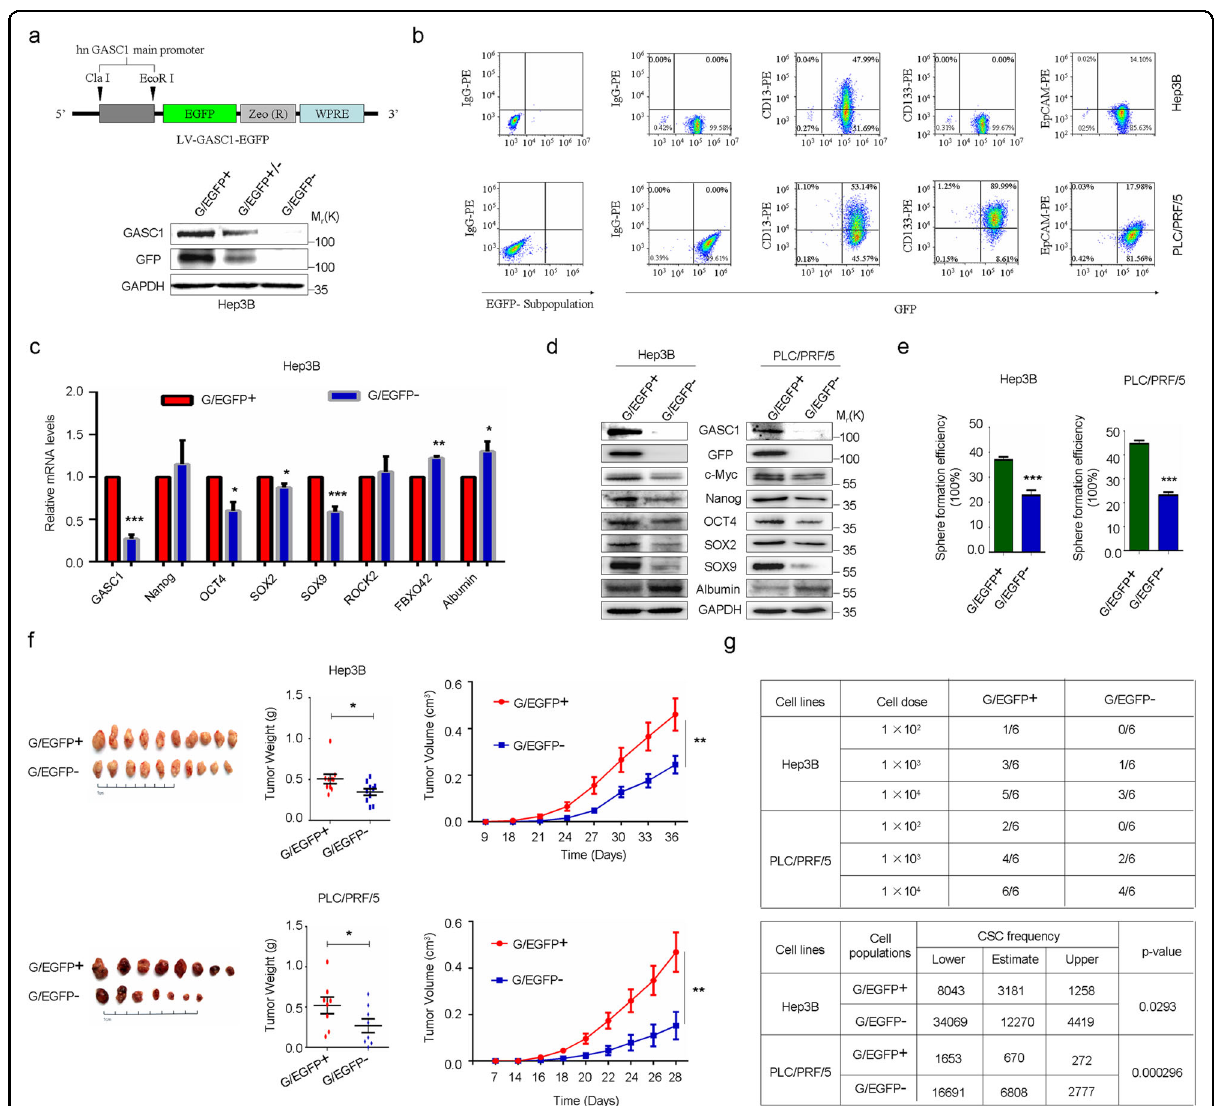
Fig. 2 GASC1 expression de fi nes the label-retaining CSC characterization in HCC. a Schematic map of lentiviral vector LV-GASC1-EGFP, in which EGFP and Zeocin expression were controlled by human GASC1 promoter (upper panel). Immunoblot (IB) of sorted populations showed a signi fi cant positive correlation between exogenous EGFP and endogenous GASC1 expression in Hep3B cells after infection with LV-GASC1-EGFP (lower panel). b Flow cytometric determination of the co-expression of G/EGFP + with CD13, CD133, or EpCAM in HCC cell lines (Hep3B and PLC/PRF/5); the G/ EGFP- subpopulation represents a negative control group. c , d qRT-PCR ( c ) and immunoblotting ( d ) evaluation of the mRNA and protein levels of indicated genes in FACS-sorted subpopulation (G/EGFP + and G/EGFP − ). Data are presented as mean ± SEM of three independent experiments. * P < 0.05; ** P < 0.01; *** P < 0.001 by Student ’ s t test. e The G/EGFP + subpopulation showed an increased oncosphere formation capacity at Day 14 of the assay. Data are presented as mean ± SEM of three independent experiments. *** P < 0.001 by Student ’ s t test. f Xenograft tumor growth assay of sorted G/EGFP + and G/EGFP- subpopulation of Hep3B and PLC/PRF/5 cells in NOD/SCID mice. Tumor image (left panel) and tumor weight (middle panel) are presented. Tumor growth was measured at the indicated time points and tumors were dissected at the endpoint ( n = 8 – 10 tumors) (right panel). Data are presented as mean ± SEM. ** P < 0.01 by two-way ANOVA. g The sorted G/EGFP + and G/EGFP − subpopulation of Hep3B and PLC/ PRF/5 cells were serially diluted and injected subcutaneously in the NOD/SCID mice for extreme limiting dilution analysis (ELDA, http://bioinf.wehi.